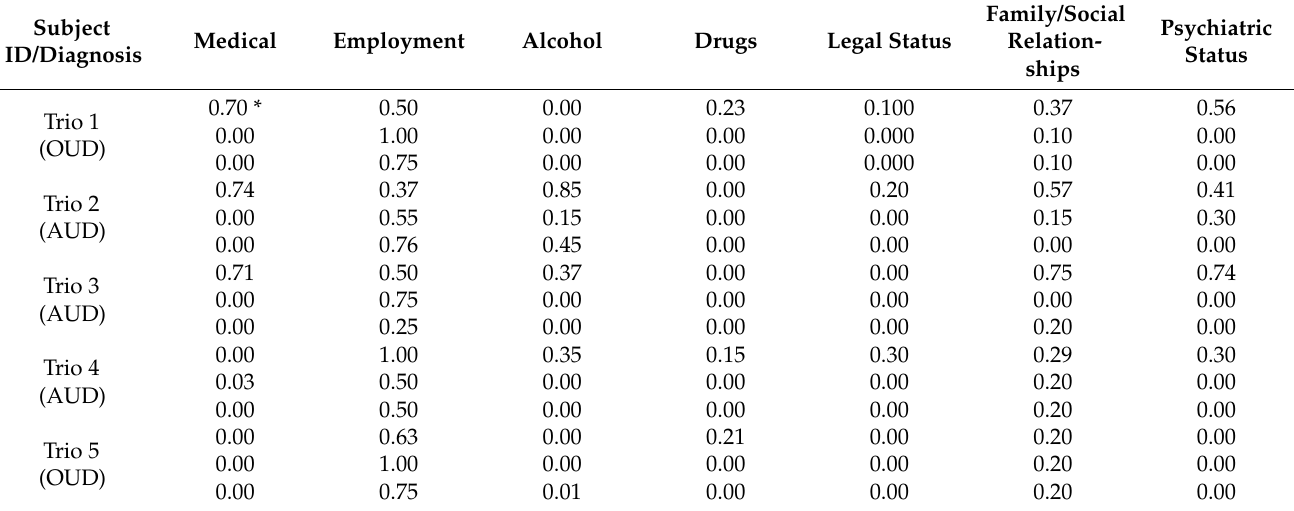
Table 2. Addiction severity scores for seven critical